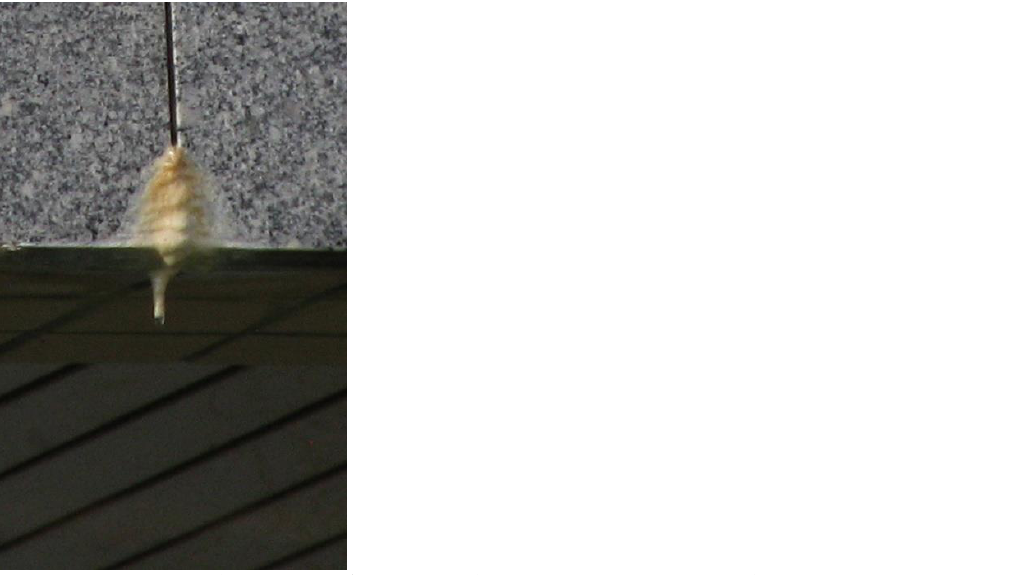
Figure 3. Example of calcium carbonate neoformation with stalactite-like structure on a granite slab (if you look closely you might be able to see on the lower tip of the "stalactite" a drop of the solutions that are forming